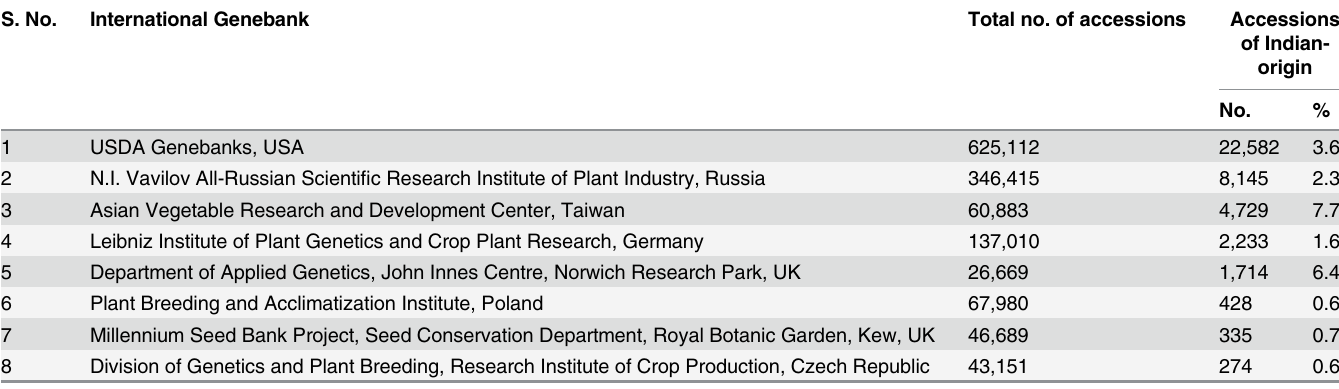
Table 2. Germplasm of Indian-origin conserved in major national genebanks. S. No.